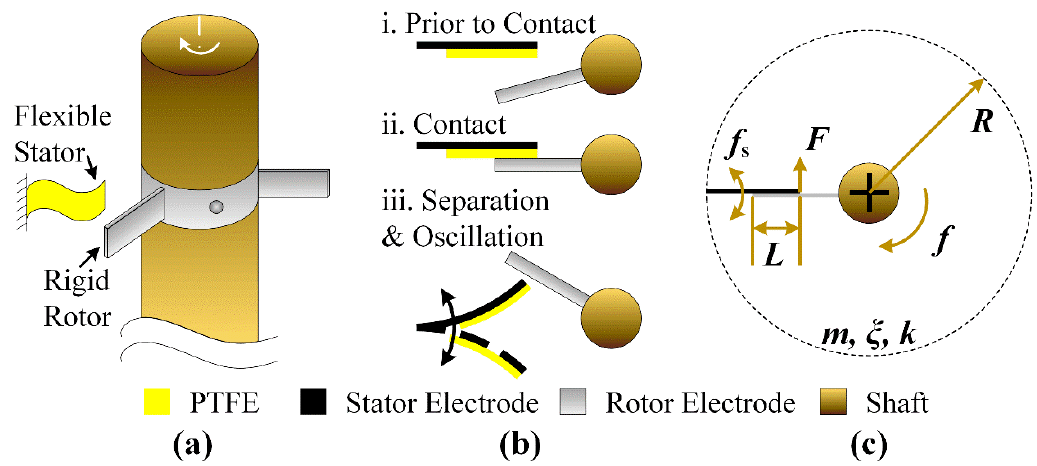
Figure 1. Triboelectric tachometer with low friction force: ( a ) Configuration; ( b ) Dynamic mechanism; ( c ) Model